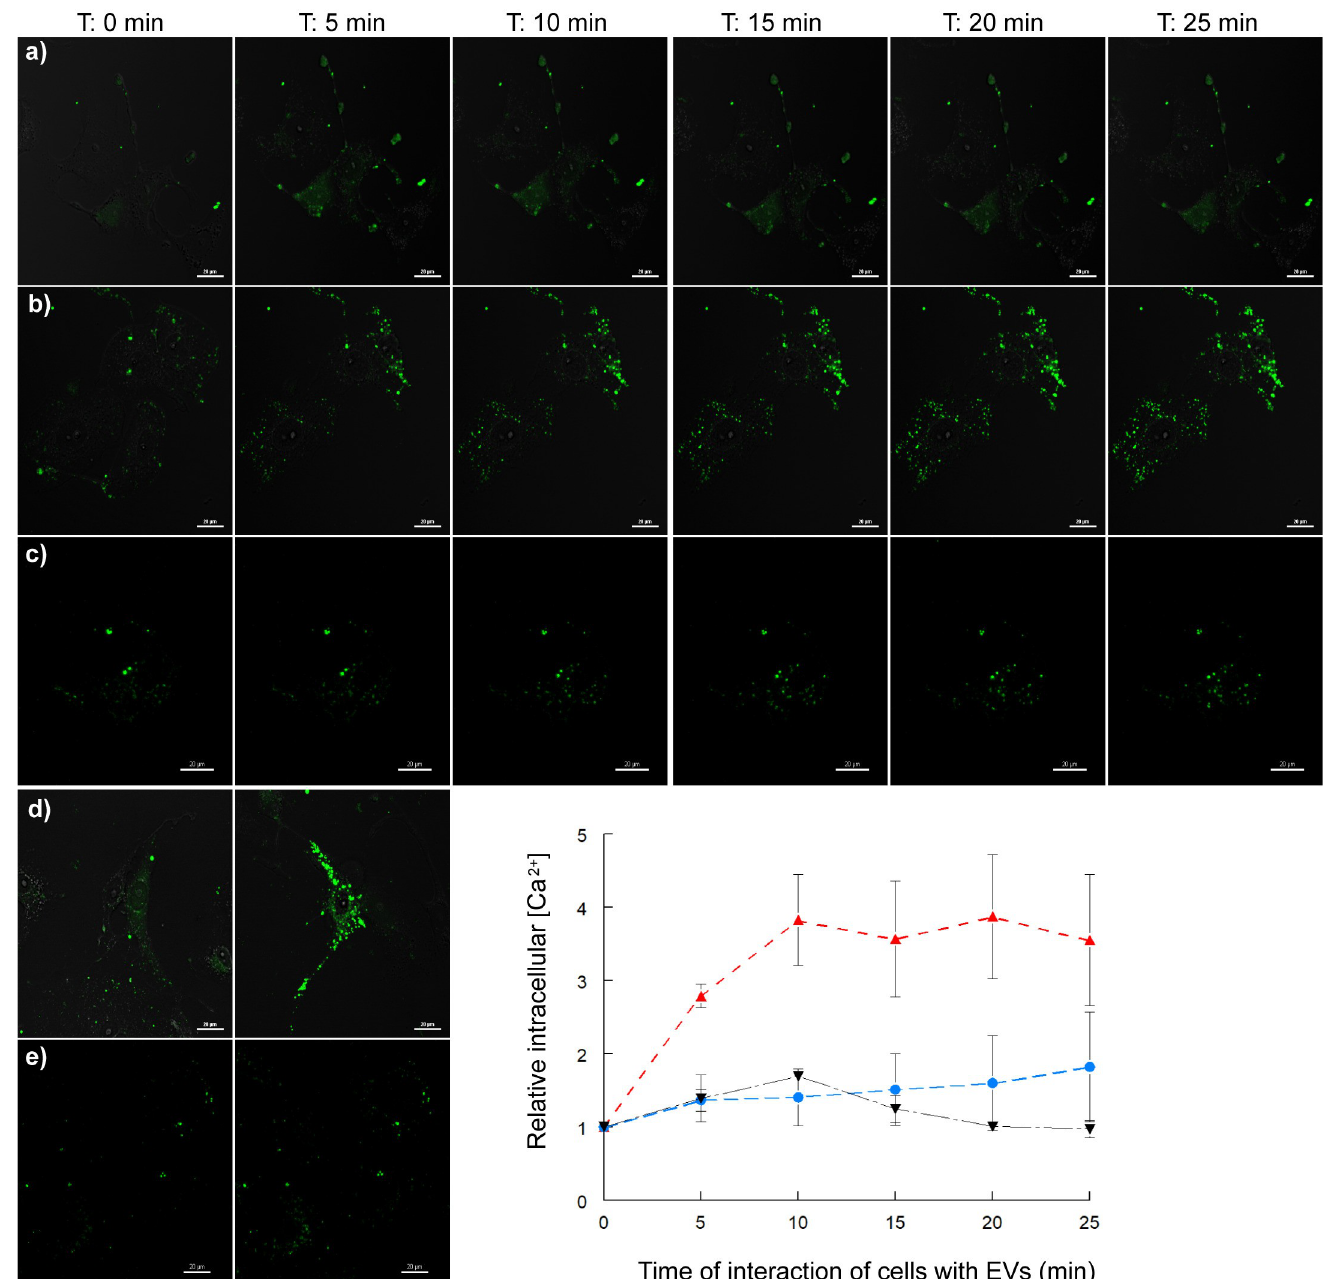
Fig 3. Analyses of the intracellular Ca 2+ mobilization in Vero cells incubated with EVs of T . cruzi . Cells were incubated with Fluo4-AM, washed, and then incubated with EVs of T . cruzi , with examination every 5 min using confocal microscopy. When the cells were incubated in a culture medium with Ca 2+ and Mg 2+, the fluorescence levels progressively increased up to 3.83 ± 0.62 times the initial values as soon as 10 minutes of the interaction (red line). At the same time point, when the cells were incubated with EVs in a culture medium depleted of Ca 2+ , there was an increase of 1.40 ± 0.39 times in the fluorescence levels when compared to the time 0 (blue line). Also, when the cells were incubated with 2.5 μ M EDTA, a calcium chelator, there was a 1.69 ± 0.01 increase in the fluorescence levels at 10 min of incubation, when the fluorescence intensity started to decrease and it was possible to observe a more granulated pattern of fluorescence in the cytoplasm (black line). The calcium ionophore A23187 and the cAMP phosphodiesterase inhibitor IBMX were employed as the positive controls of the experiment. A23187 prompted a 64.80-fold rise in the fluorescence levels at 25 min and IBMX prompted a 2.37-fold rise in the fluorescence levels at 10 min of incubation.